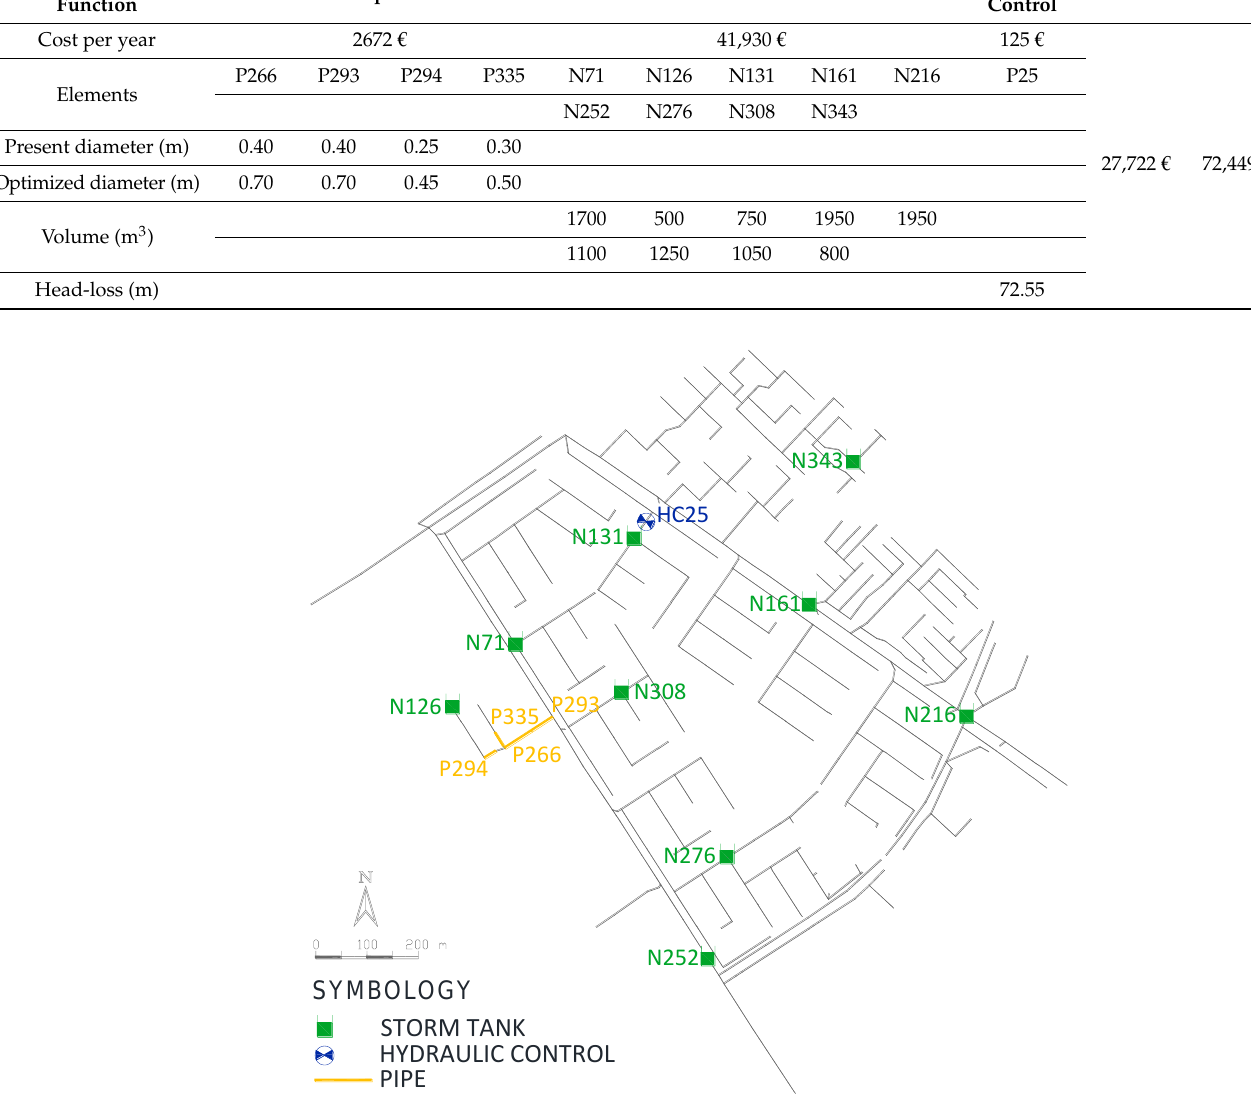
Figure 14. Location of infrastructure needed to rehabilitate the ES-N network. Table 4. Objective function of the best solution found for the ES-N network.